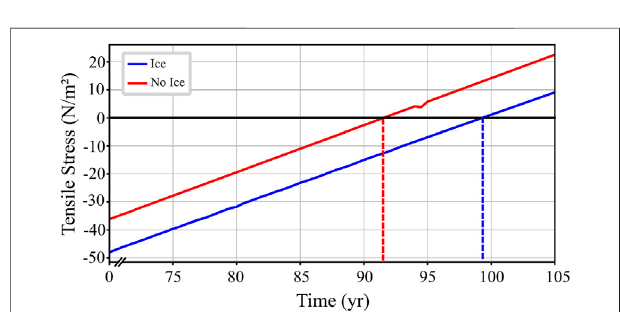
FIGURE 8 | Westdahl tensile stress versus time with and without a 1 km glacier. The fi gure has been zoomed in to highlight the timing of failure. Failure condition is represented by the black horizontal line and repose intervals are represented by the dotted lines. Depth to reservoir center is 7.2 km, fl ux rate is 0.0024 km 3 /yr, and the radius of the magma chamber is 1.39 km (based on geodetic inversions conducted by Gong,